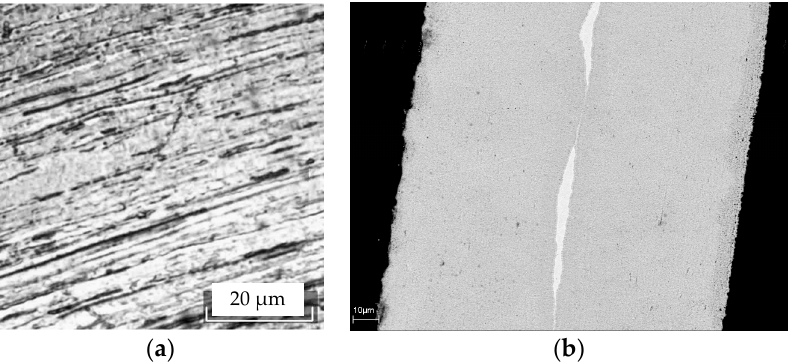
Figure 4. Microimages of a flat molybdenum plate cross ‐ section: ( a ) an original substrate after cross ‐